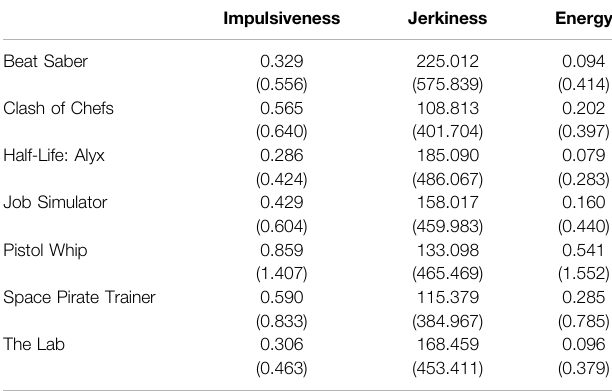
TABLE 2 | Computed mean values and standard deviations (in parentheses) for the head by game. Values are rounded to three